Question: Generate an informative caption for the figure above.
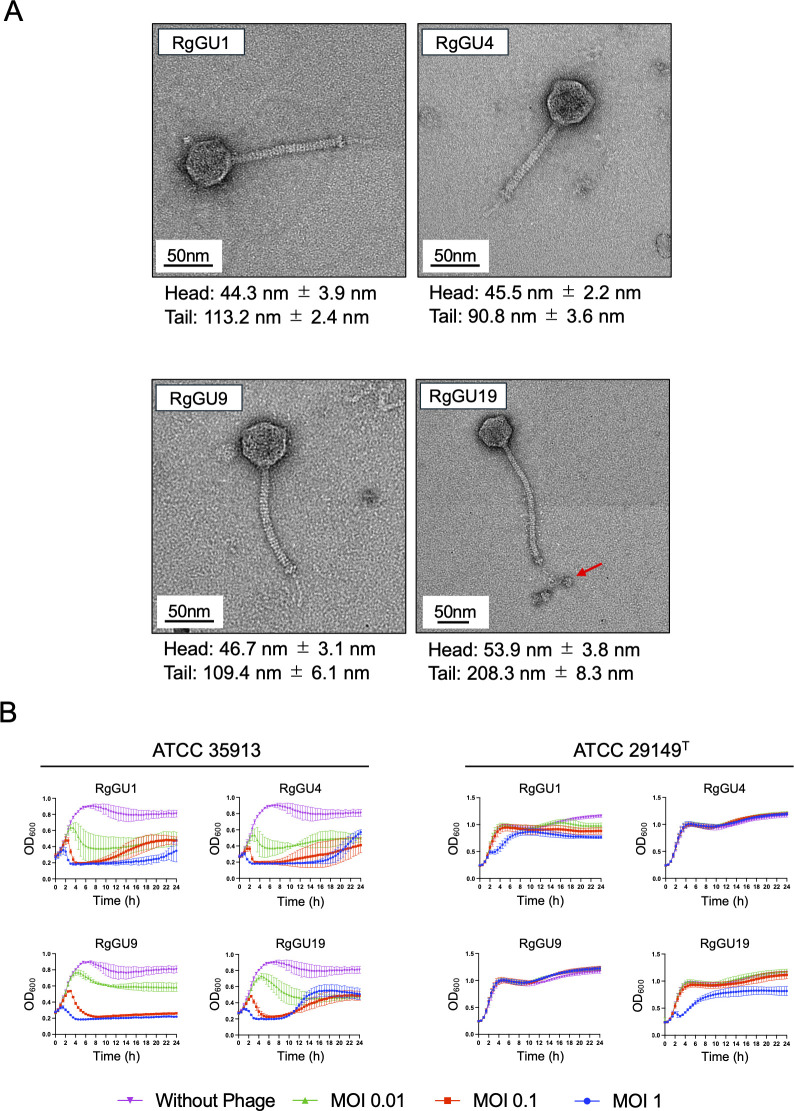
Answer: Morphological and growth characterization of representative R . gnavus phages. ( A ) Phage lysates were negatively stained with uranyl acetate and visualized using a TEM JEM-2100 (JEOL). Scale bar: 50 nm. The lengths of the head and tail were measured using ImageJ (NIH, USA; version 1.54g). The mean values and standard deviations of at least seven phage particles are shown. Red arrow showed appendages observed at the distal part of tail fibers. ( B ) Killing curves of R. gnavus strains ATCC 35913 and ATCC 29149 T were determined as follows: host bacteria were infected with representative R. gnavus phages at MOIs ranging from 0.01 to 1. Bacterial growth without the phage was used as a control. All experiments were performed in triplicate, and the error bars represent the mean ± SD.